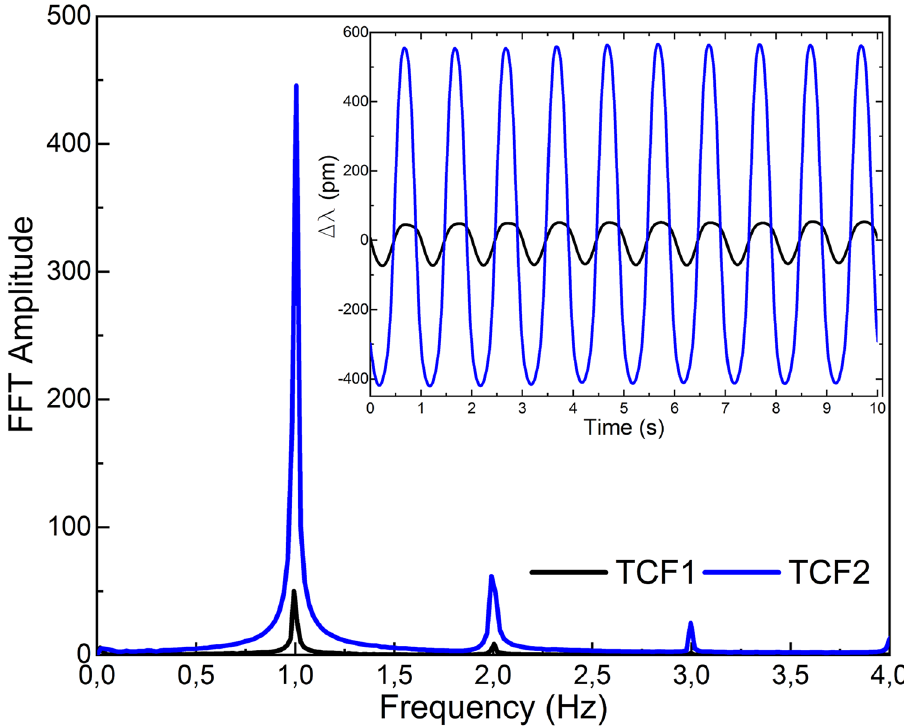
Figure 7. Results in frequency domain when both devices were vibrating. Results in time domain are shown in the